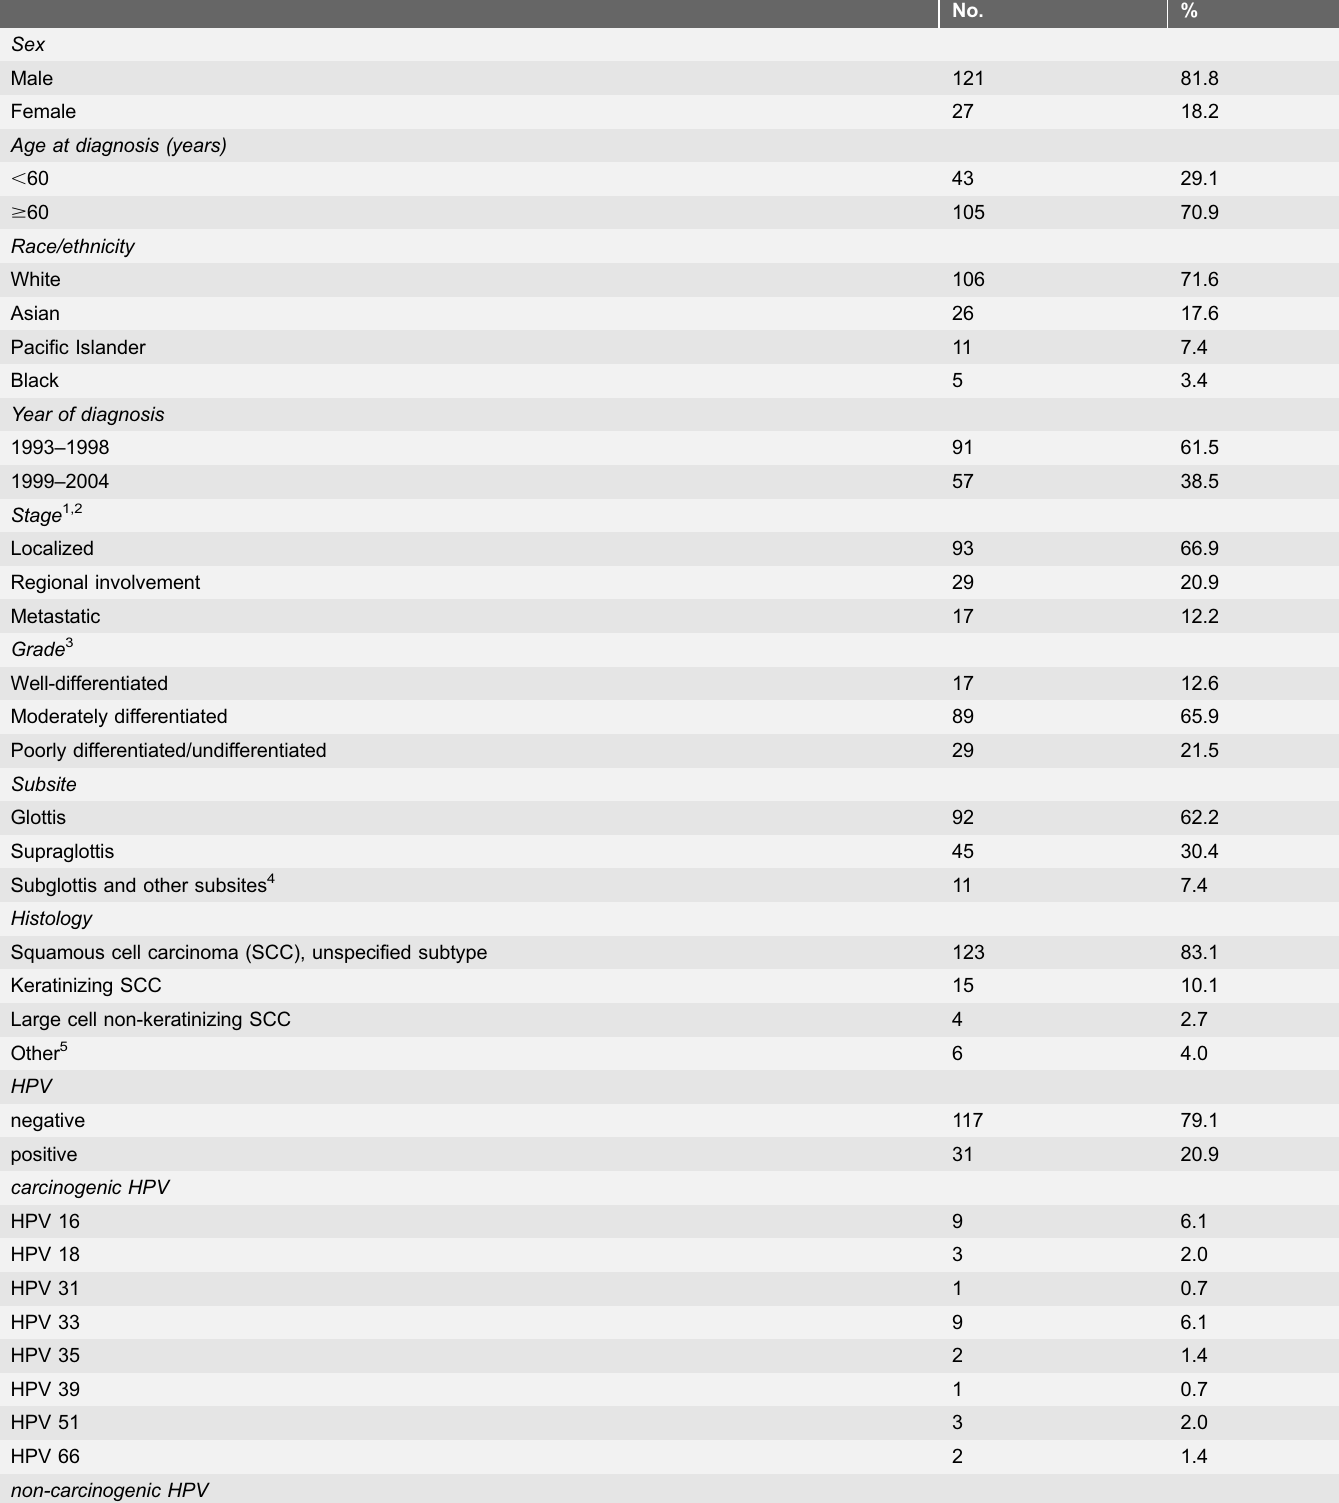
Table 1. Characteristics and HPV status of invasive laryngeal cancer cases (n 5